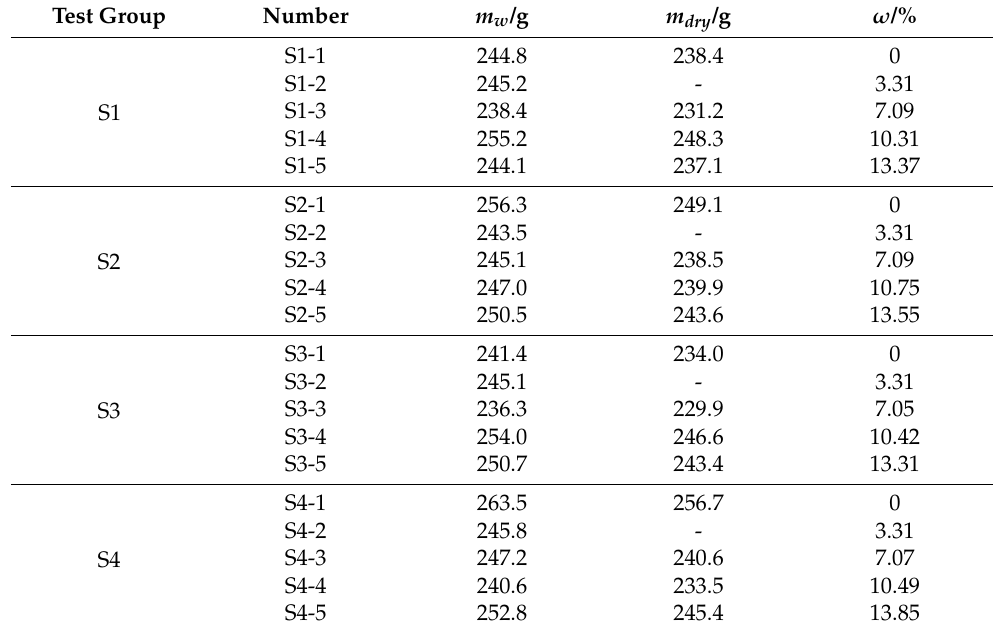
Table 1. The water content of coal samples was tested in four parallel test